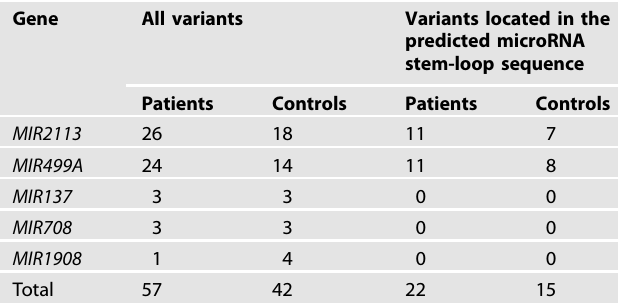
Table 3. MicroRNA-based distribution of the identi fi ed rare sequence